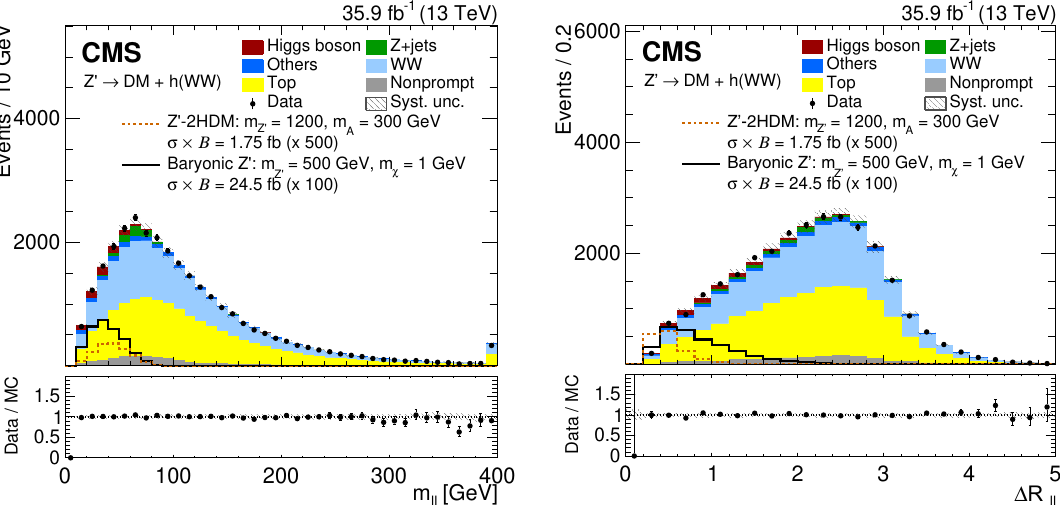
Figure 3 . The distribution of m (left) and (cid:1) R (right) after the preselection, expected from MC ‘‘ ‘‘ simulation (stacked histograms) and observed in data (points with vertical bars). The systematic uncertainties, discussed in section 7.1, are shown by the hatched region. Two signal benchmarks, corresponding to the Z 0 -2HDM (dotted orange line) and baryonic Z 0 (solid black line) model are superimposed. The signal is normalized to the product of cross section and , where represents B B the h WW branching fraction. The signal distributions are scaled up by a factor 500 (100) for ! the Z 0 -2HDM (baryonic Z 0 model), to make them more visible. The lower panel shows the ratio of the data to the predicted SM